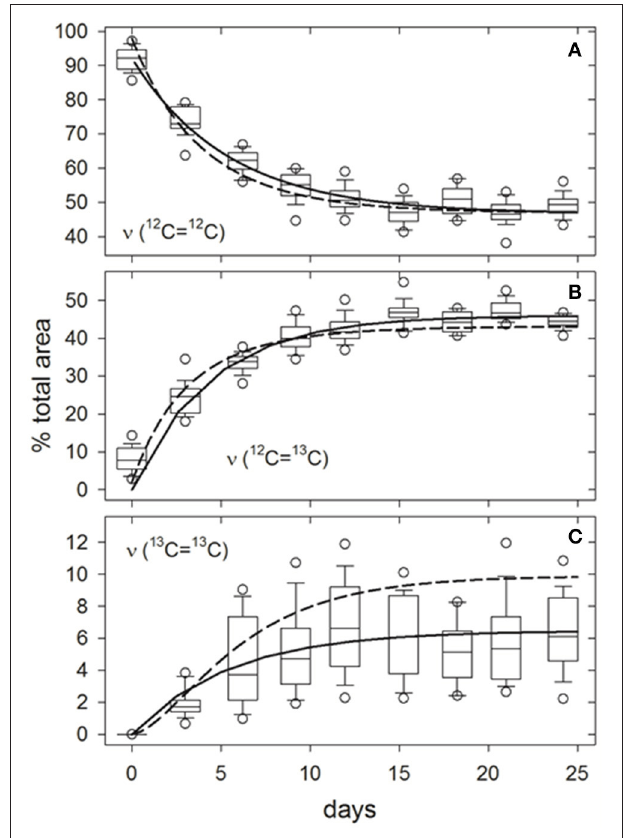
FIGURE 3 | Example of growth-dependent variations in the relative proportions of ν ( 12 C = 12 C) (A) , ν ( 12 C = 13 C) (B) , and ν ( 13 C = 13 C) (C) isotopologue bond peak areas to the total ν (C = C) Raman peak area at ∼ 1,521 cm − 1 for carotenoids in Synechococcus sp. (RS9916) cells grown in 0.32 f media . Boxes represent the interquartile range (25–75th percentiles) for peak areas in spectra from 25 ± 3 individual cells. Internal horizontal lines, whiskers, and circles are medians, 10 to 90th, and 5 to 95th percentiles for all observations, respectively. Solid curves are hyperbolic fits to all observations ( N = 250 cells). Broken lines are responses predicted from arguments presented in SM 2 and SM 3, particularly Equations (S11,